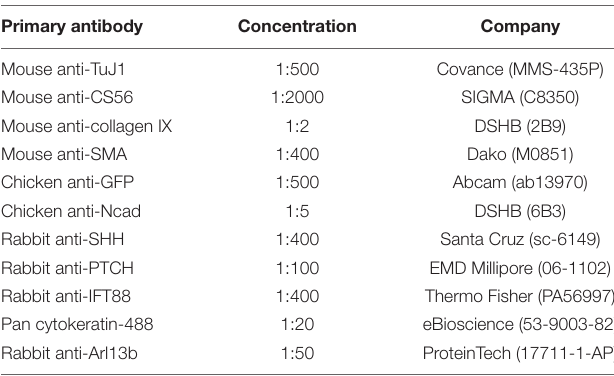
TABLE 1 | Primary antibodies for immunohistochemistry studies.